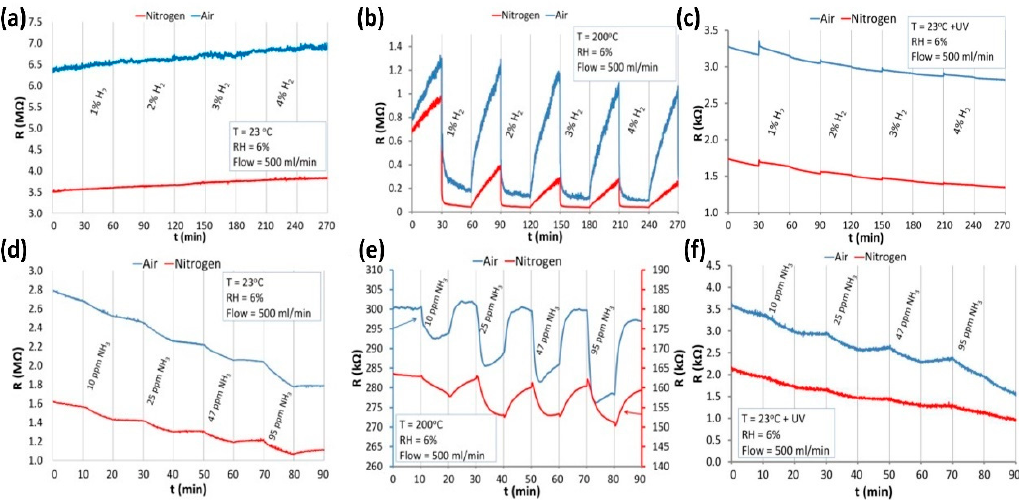
Figure 23. H 2 sensing of ZnO nanostructures in different atmospheres of synthetic air and nitrogen: ( a ) RT; ( b ) evaluated temperature of 200 °C; ( c ) RT and UV irradiation. NH 3 sensing of ZnO nanostructures in air and nitrogen: ( d ) RT; ( e ) 200 °C; ( f ) RT and UV irradiation. Reproduced with permission from [44].